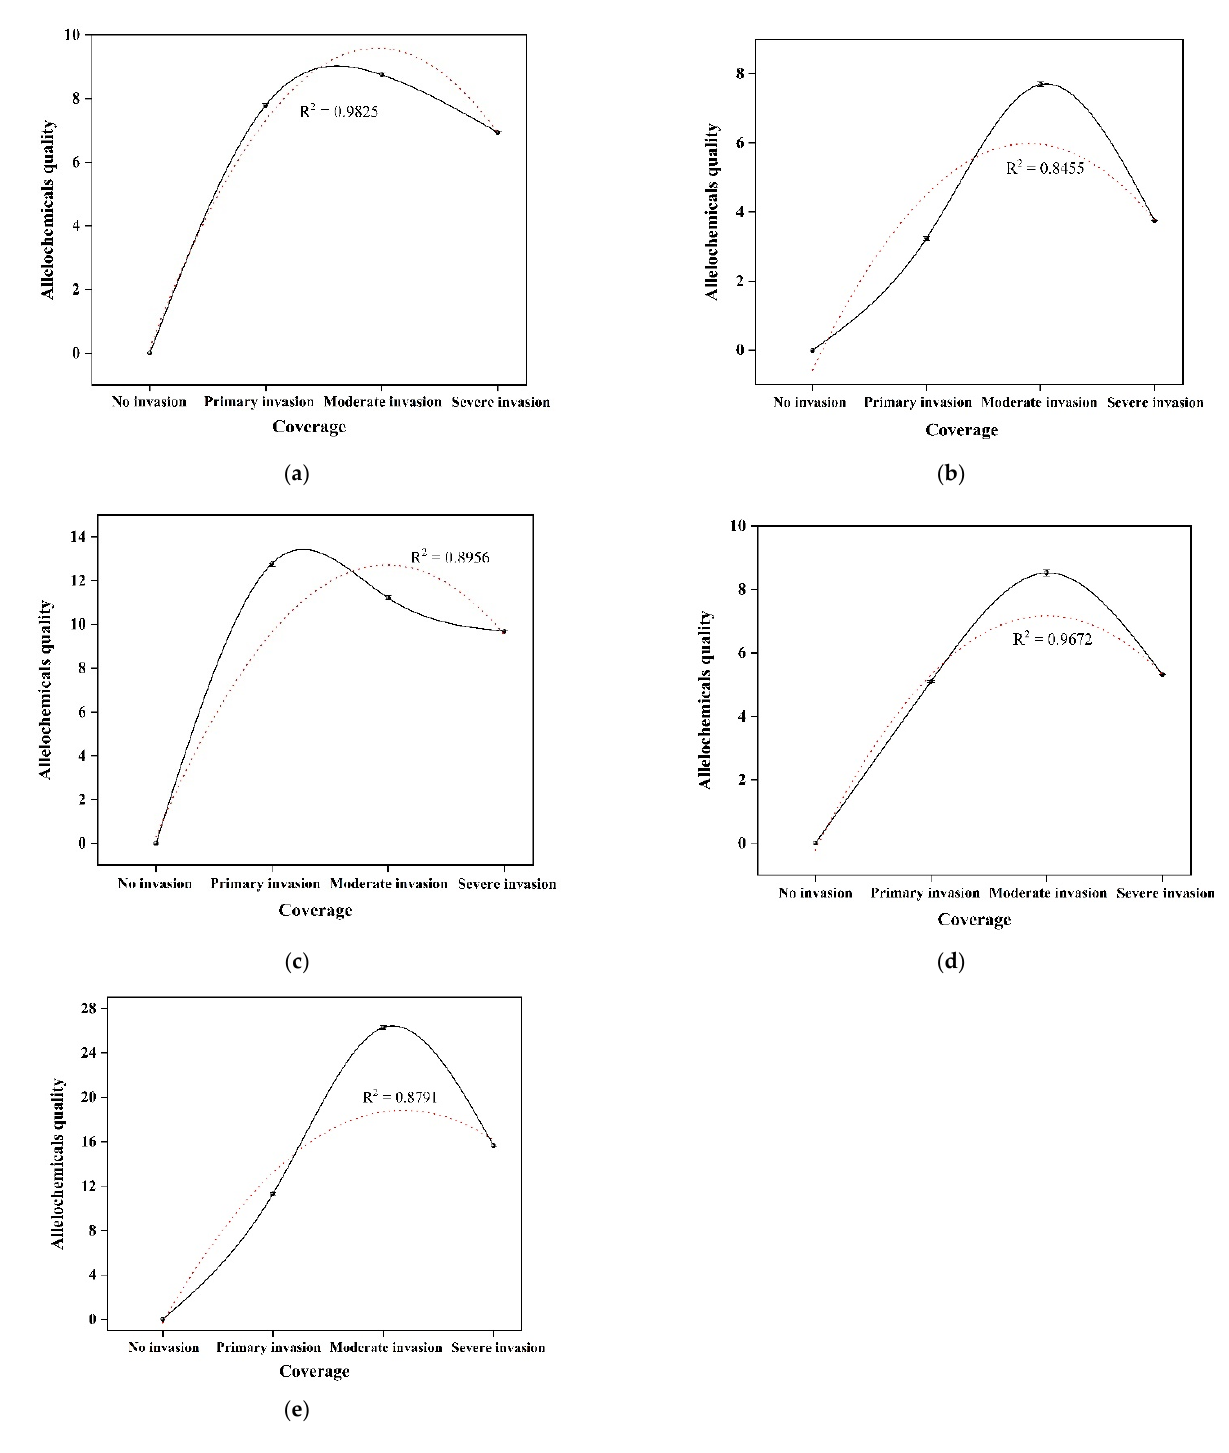
Figure 1. The relationship between growth coverage and quantity of allelochemicals: ( a ) chamae- chromone; ( b ) mesoneochamaejasmin A; ( c ) neochamaejasmin B; ( d ) dihydrodaphnodorin B; and ( e ) 7-methoxyneochamaejasmine